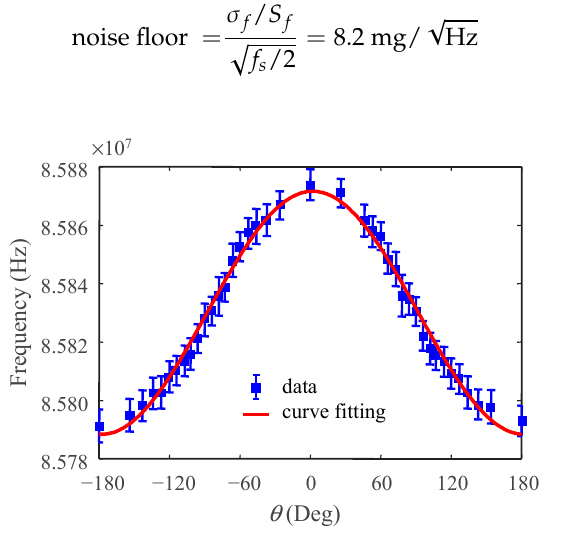
Figure 12. Static acceleration test.